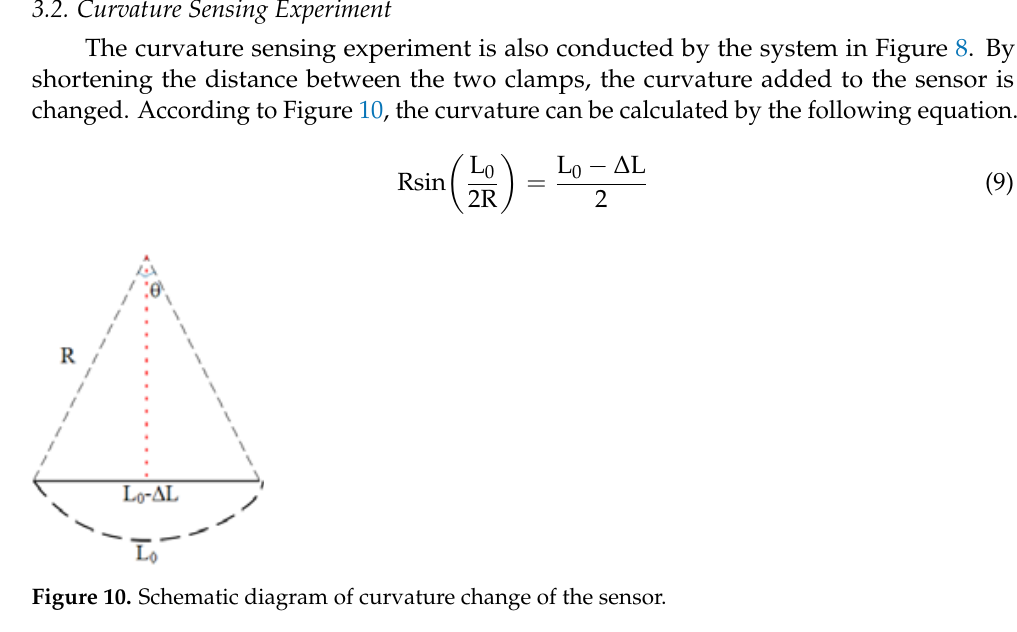
Figure 9. ( a ) Transmitted spectra of the SCSHF sensor under different axial strains; ( b ) linear fitting curve between dip wavelength and axial strain.